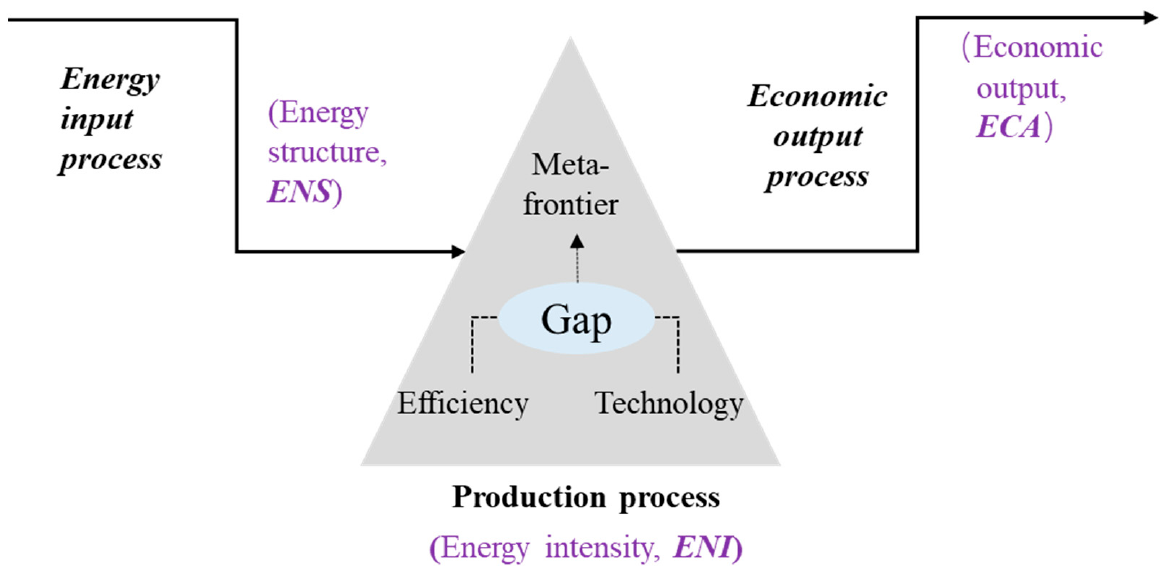
Figure 1. Multi‑process decomposition